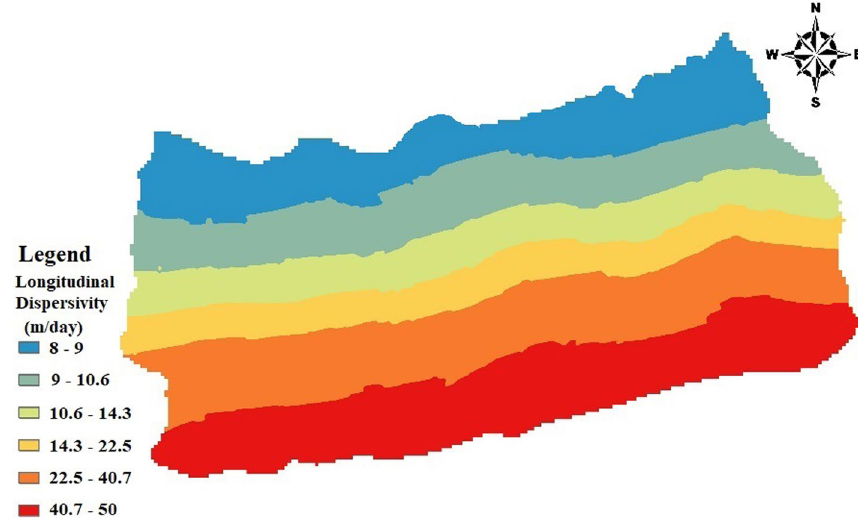
Fig. 9 Aquifer-wide spatial distribution of longitudinal